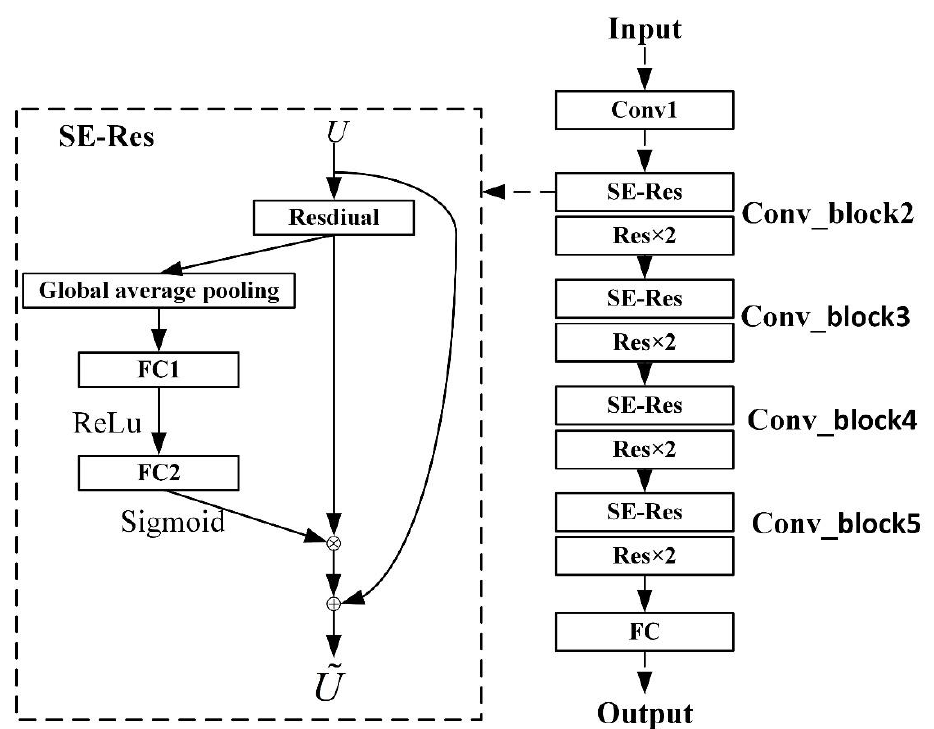
Figure 4. The structure of SE-ResNet50.